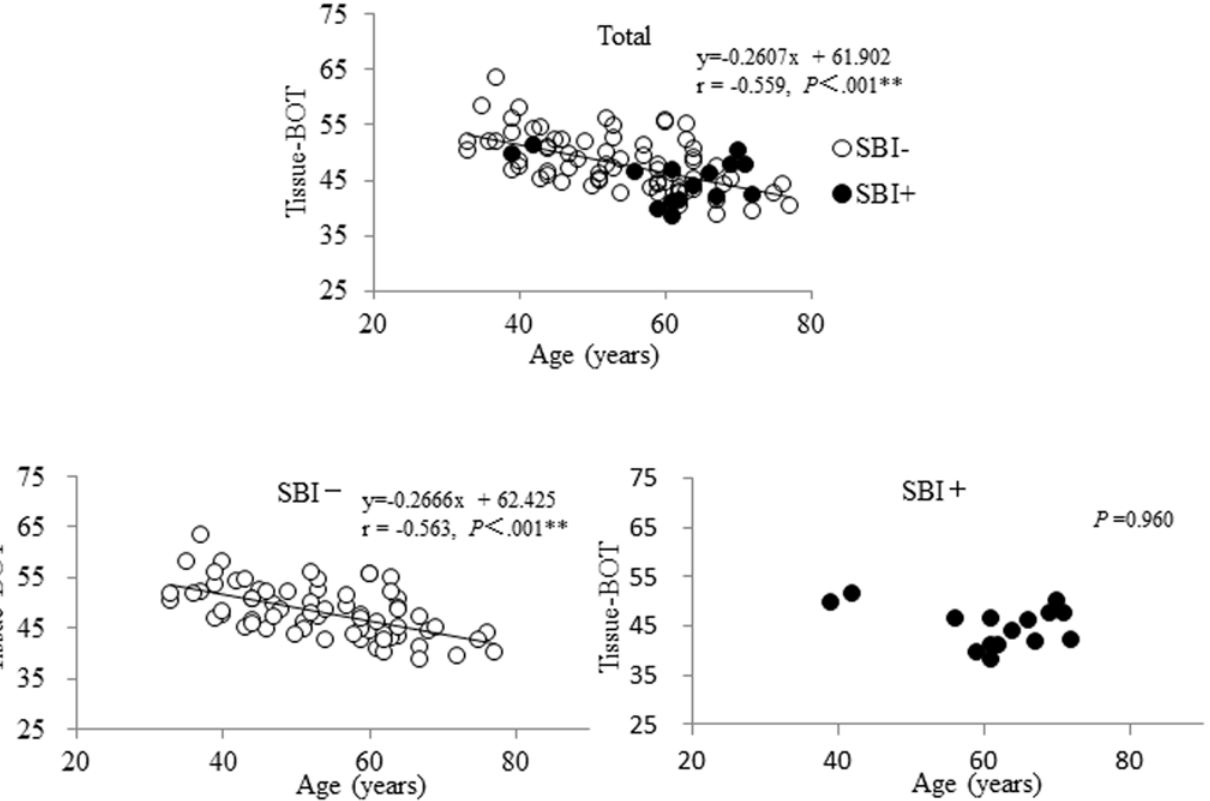
Fig 1. Relationship between age and blowout time in patients with primary aldosteronism. All patients with primary aldosteronism (PA) showed a correlation between tissue blowout time (BOT) and age (r = -0.559, P < .001, upper). In PA patients without SBI, tissue BOT was closely correlated with age (r = -0.563, P < .001, left), while in PA patients with SBI, tissue BOT was not correlated with age ( P =. 96, right).